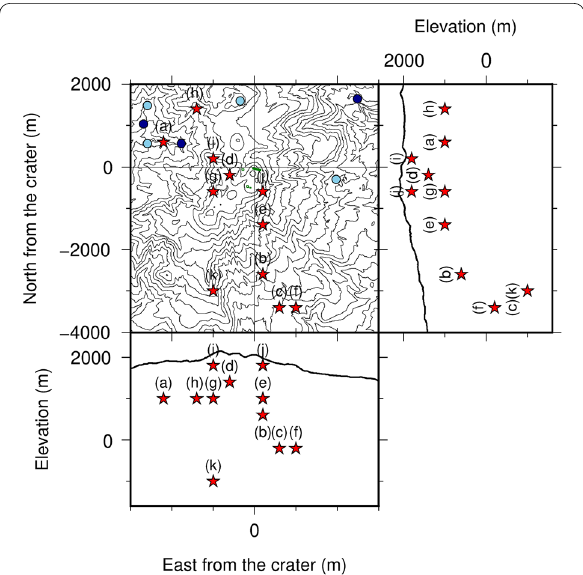
Fig. 10 Spatial distribution of all the source candidates. Candidates are indicated by red stars. The green lines represent the eruptive crater rows estimated by GSI (2018b). The light blue circles represent the locations of fumaroles. The dark blue circles represent the locations of hot springs